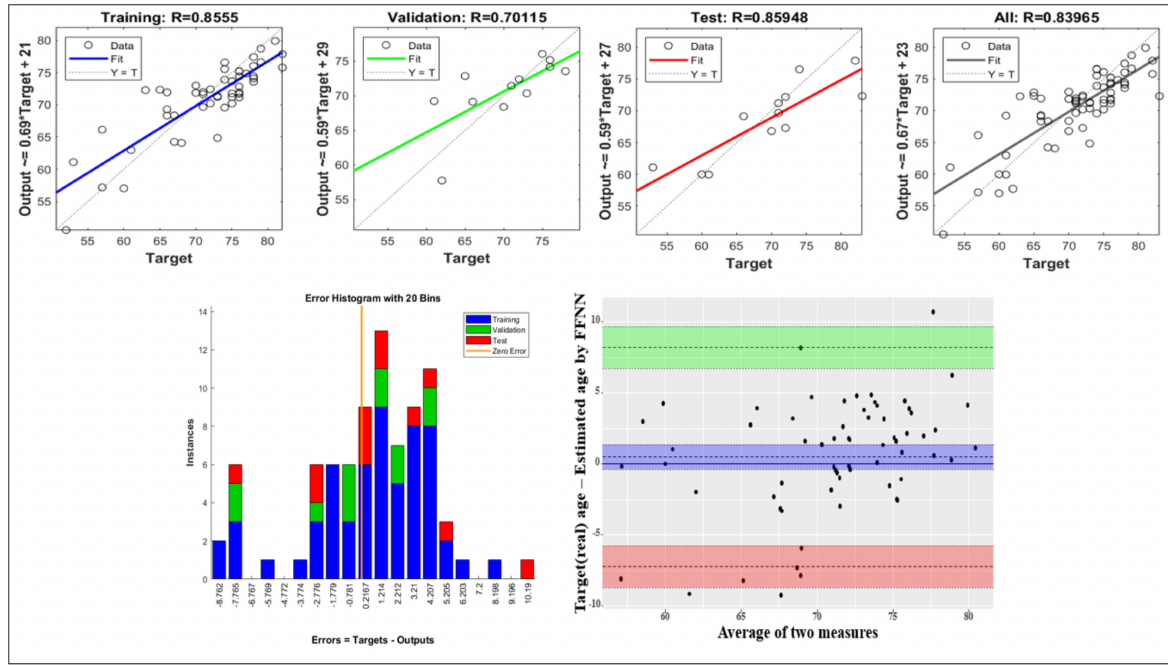
Figure 7. Result of neural network regression, Error histogram & Blond-Altman